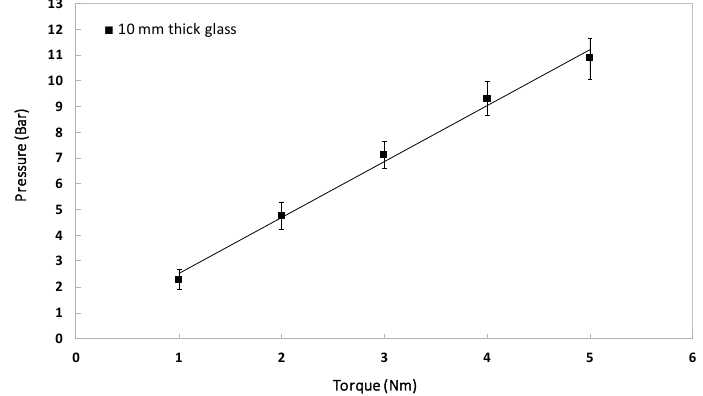
Figure 3. Pressure applied in the final composite vs. the torque used to grip the tool.